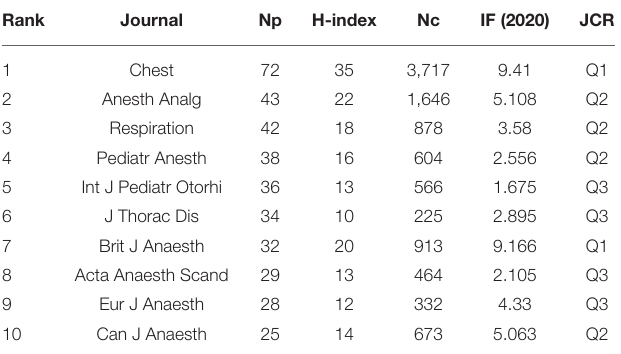
TABLE 1 | The top 10 most active